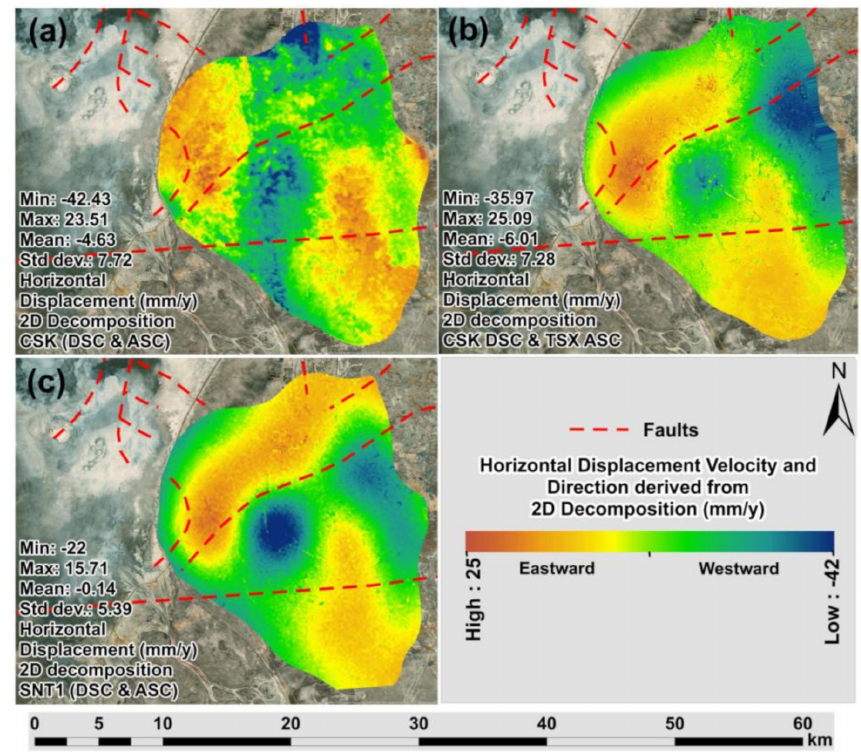
Figure 13. Maps of horizontal displacement velocity (2018–2020) derived from 2D decompositions of: